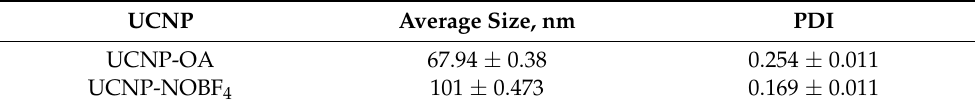
Figure 2. Characterization of UCNP-OA core/shell structure (NaY 0.794 F 4 : Yb 0.2 , Tm 0.06 /NaYF 4 ) and UCNP-NOBF 4 : ( a ) TEM image of UCNP-OA, scale bar 20 nm; ( b ) UCNP in suspension illuminated by a laser with a wavelength of 980 nm; ( c ) photoluminescence (PL) emission spectrum of UCNP-OA and UCNP-NOBF 4 under excitation at 980 nm; ( d ) hydrodynamic diameter distributions of UCNP-OA and UCNP-NOBF 4 acquired by DLS in hexane and deionized water, respectively. Table 1. The hydrodynamic diameter of UCNP-OA and UCNP-NOBF 4 acquired by dynamic light scattering (DLS) in hexane and deionized water,